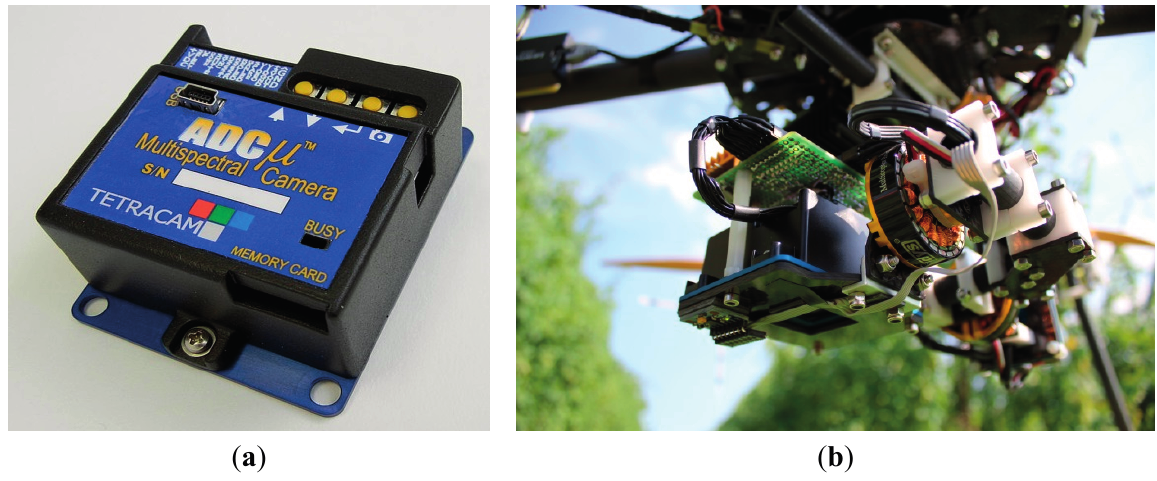
Figure 4. The multispectral camera TETRACAM ADC Micro ( a ). The tested multispectral gimbal ( b